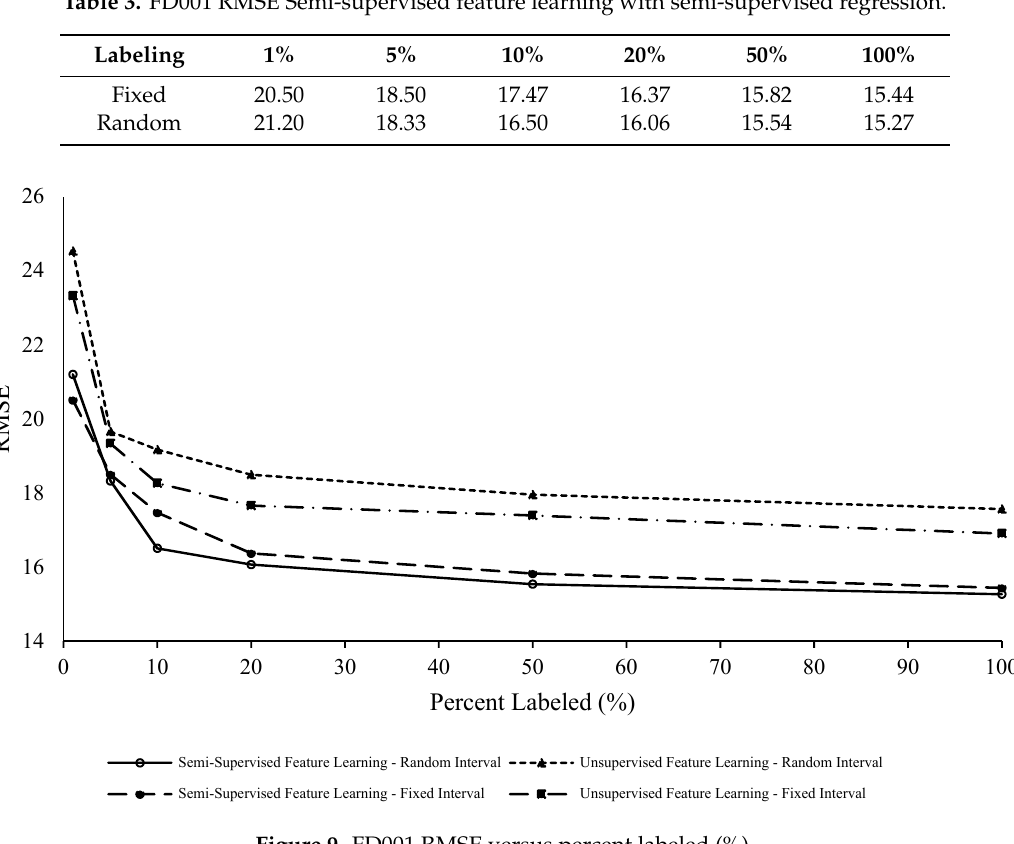
Table 3. FD001 RMSE Semi-supervised feature learning with semi-supervised regression.